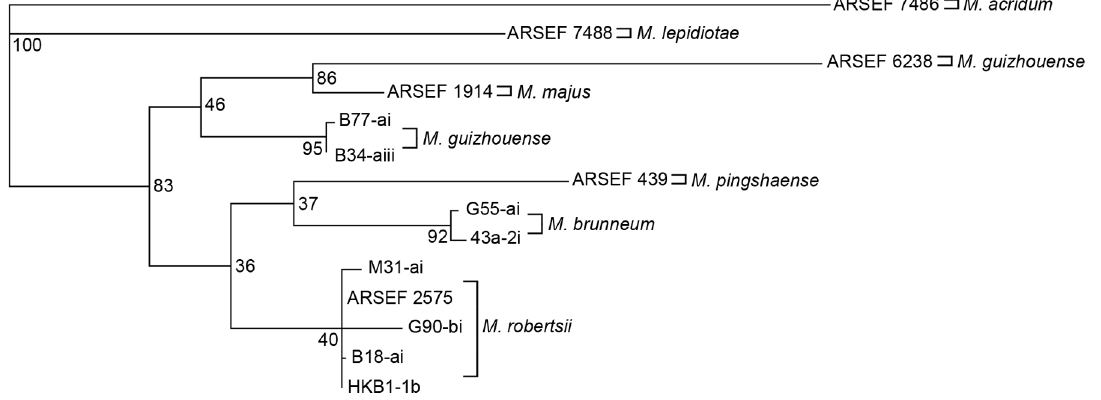
Figure 2. Maximum parsimony (MP) phylogenetic tree of Mad1 full gene sequences of Metarhizium isolates. Bootstrap values are based on 1000 pseudoreplicates.